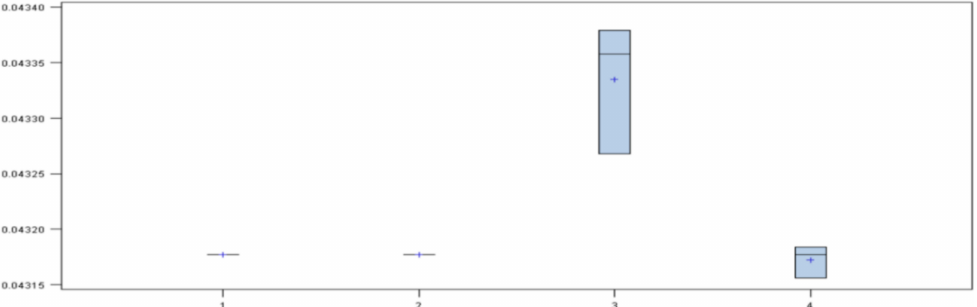
Figure 3. Box plot of the misclassification rate in gradient boosting models with sets of variables A, B and C.